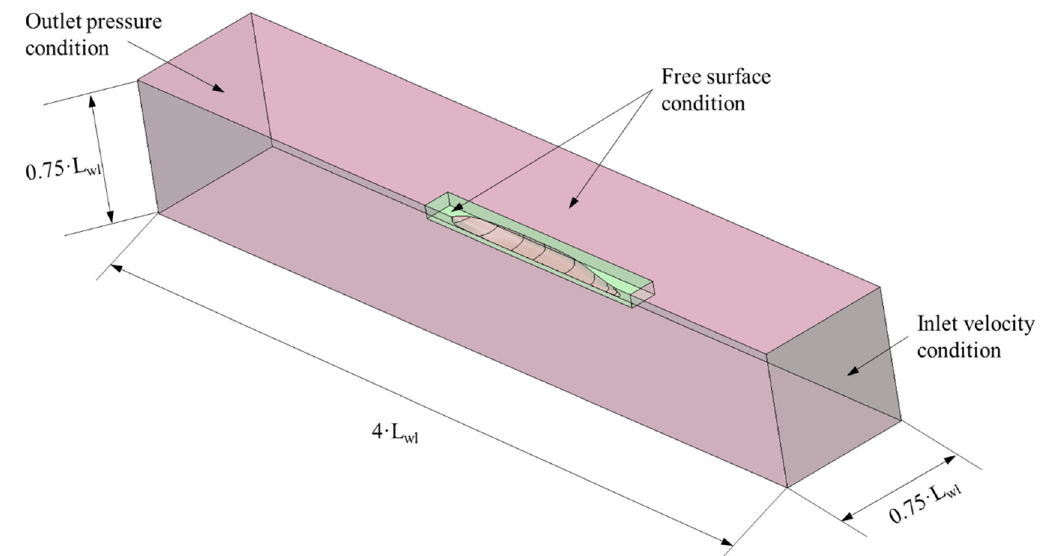
Figure 3. General view of the control volume used for computational fluid dynamics (CFD) simu- lations. Source: Own elaboration.